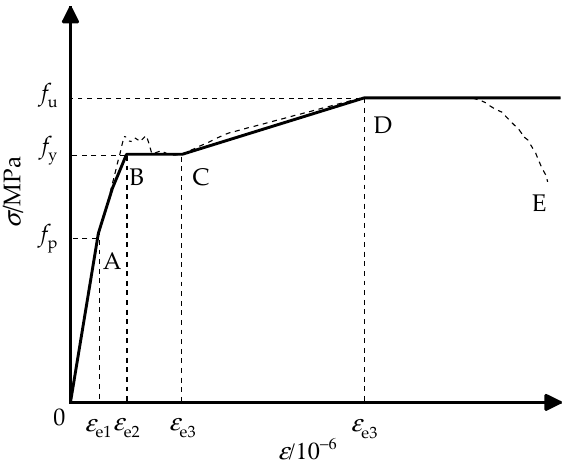
Figure 3. Stress–strain relationship of the steel tube.